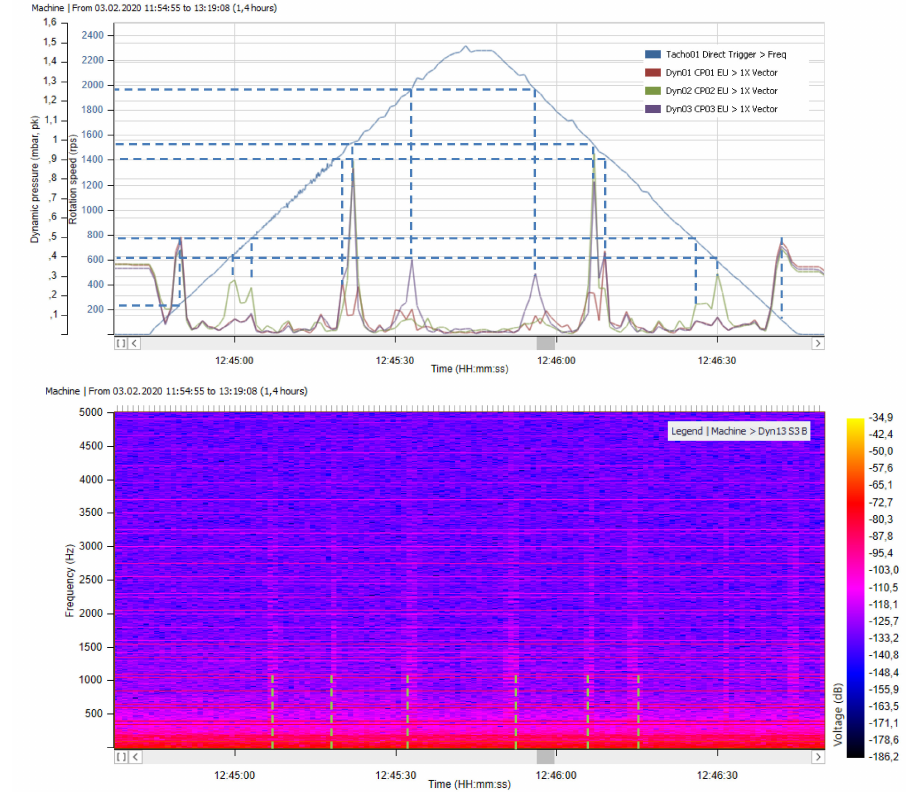
Figure 22. Comparison between the acoustic excitation ( top ) with the siren and three fast pressure probes S1 to S3, and the spectrogram of the blue component on S3 ( bottom